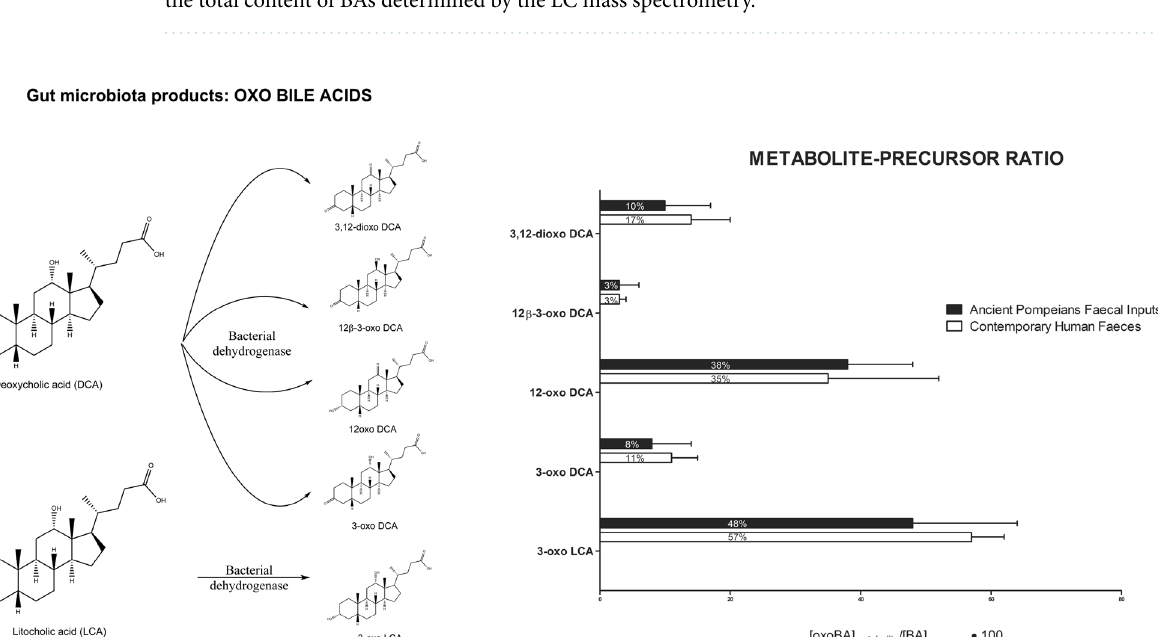
Table 1. BA and BA metabolite content in Pompeii soil and in modern human faeces. The percentages refer to the total content of BAs determined by the LC mass spectrometry.